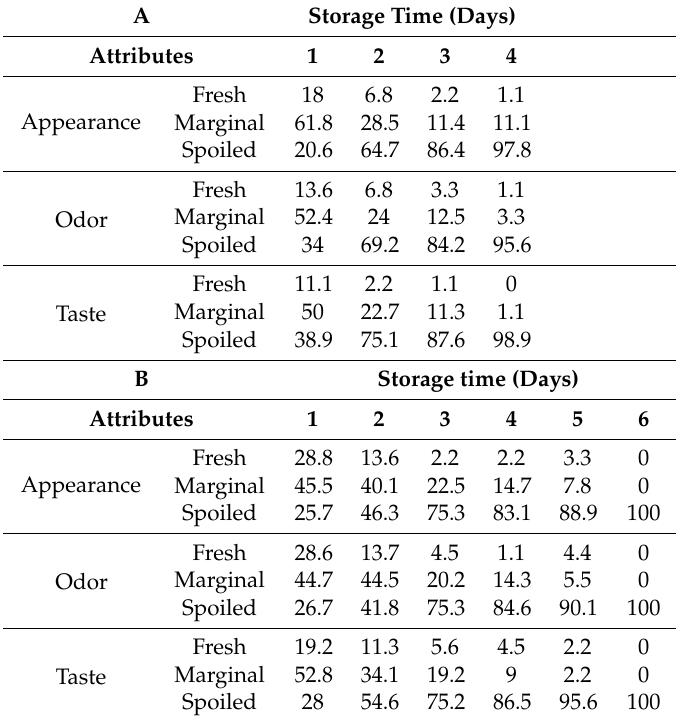
Table 4. A sensory analysis of tchapalo stored at ( A ) ambient temperature (28 to 30 ◦ C) for four days and ( B ) 4 ◦ C for six